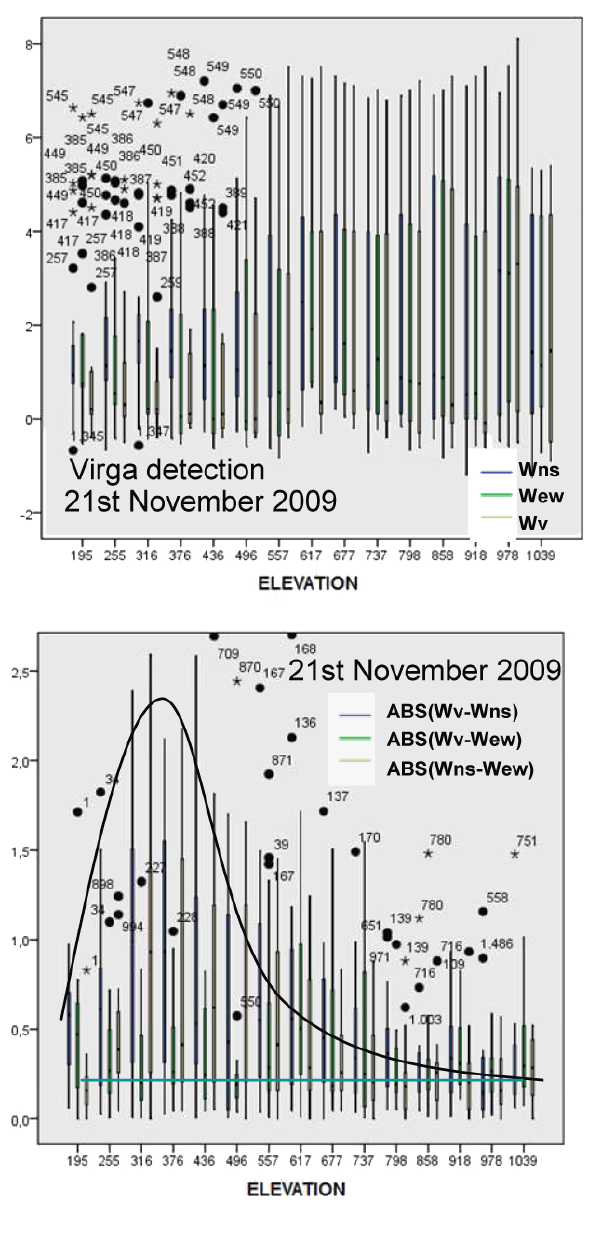
Fig. 12. South pattern: box plots on 21 November 2009. x axis (height in ma.s.l.). y axis (velocity in ms − 1 ) . (top) Vertical ve- locities versus height. (bottom) Absolute values of the differences between velocities versus height. Black line represents the envelope curve.